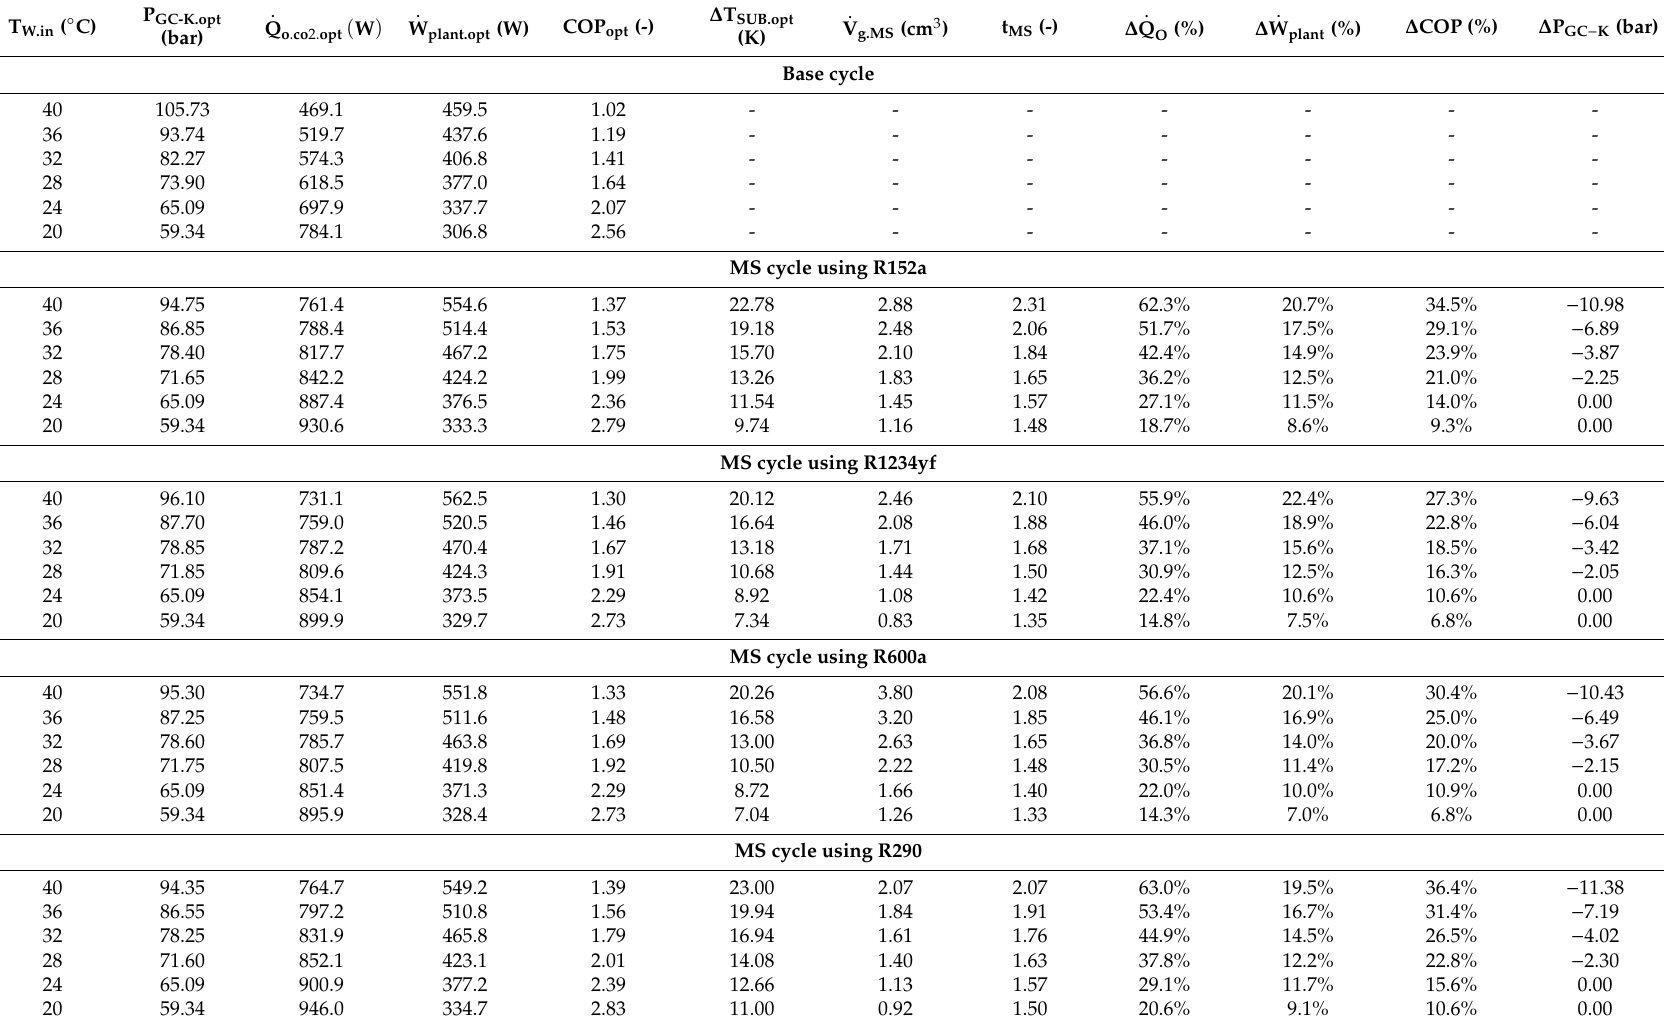
Table 10. Results at the optimal operating